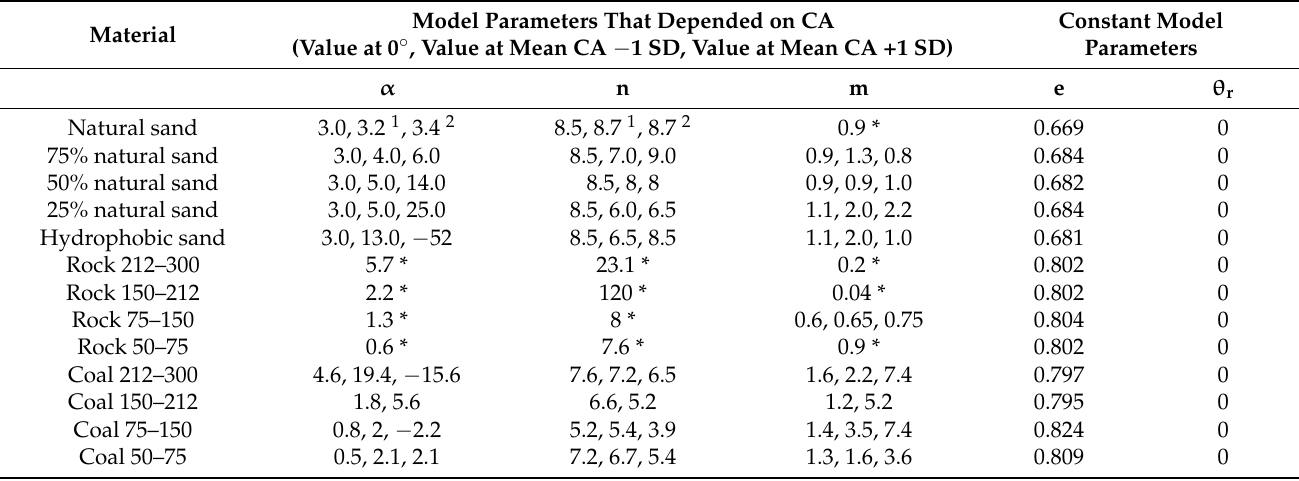
Table 3. List of the model parameters used for each material, where values of α , n and m varied for each contact angle (CA). SD = standard deviation, and all CA values are from Table